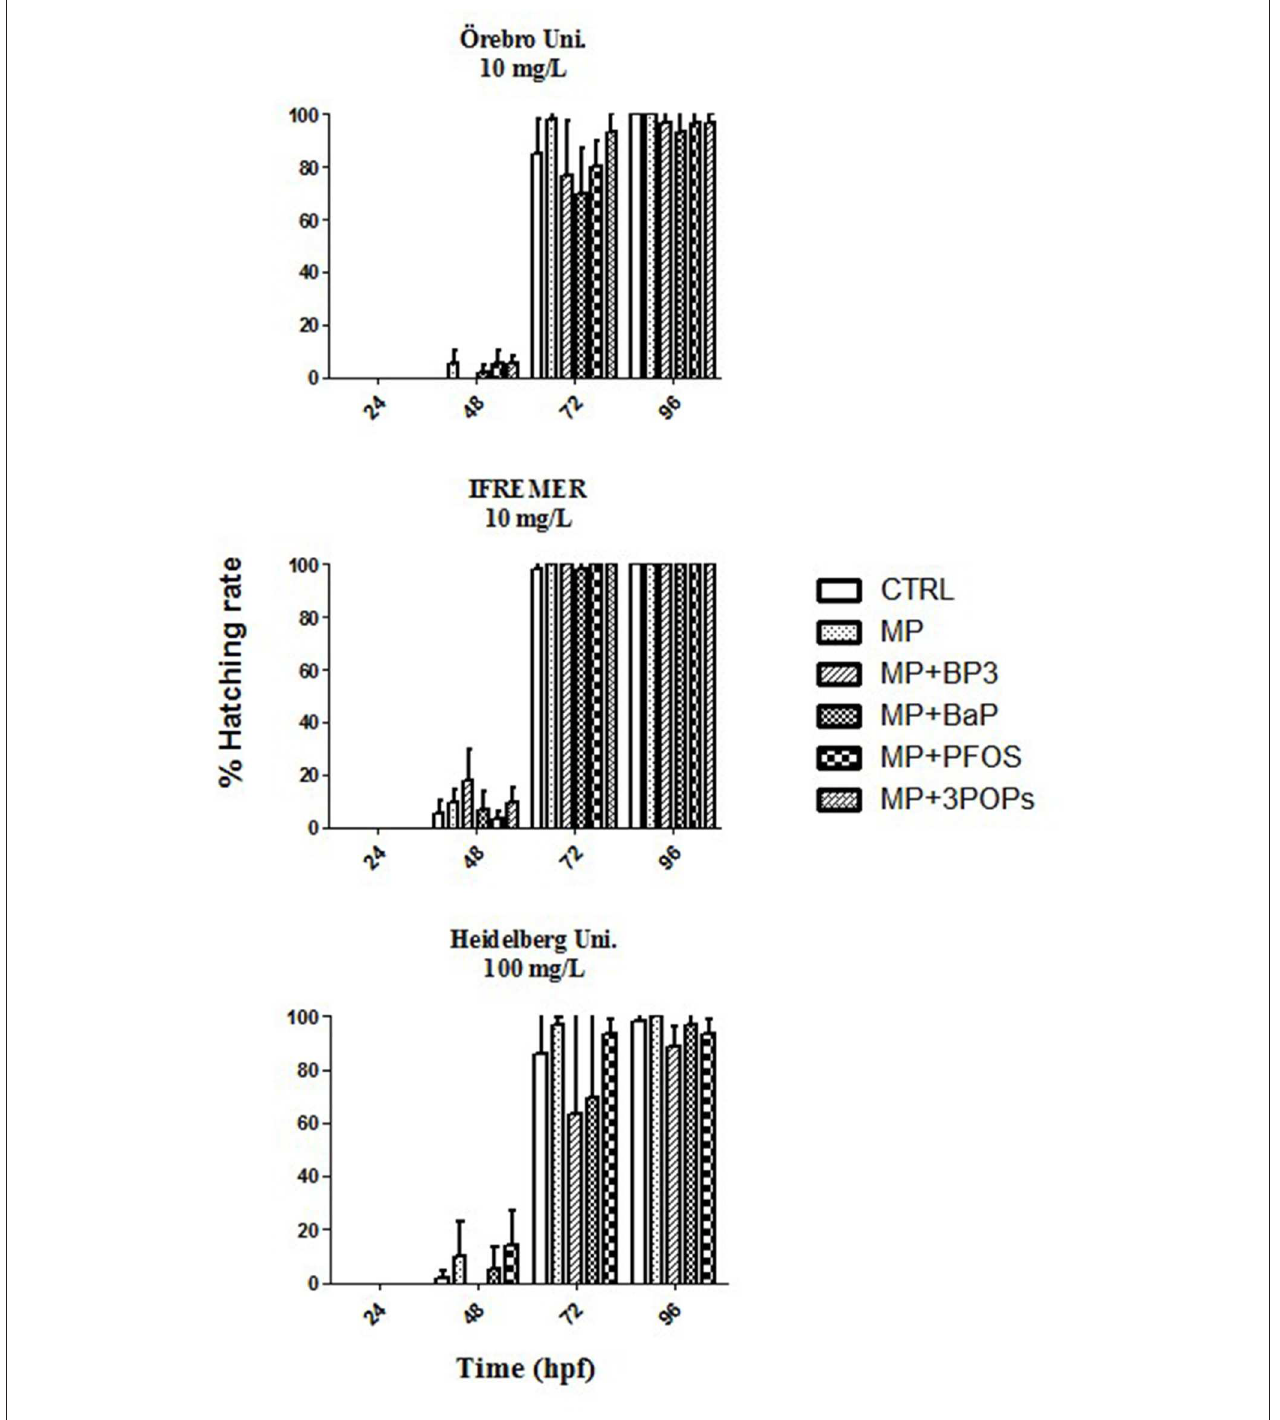
FIGURE 2 | Hatching rate of zebrafish ( Danio rerio ) embryos after 24, 48, 72, and 96h exposure to microplastics (MP) and microplastics spiked with benzophenone 3 (MP + BP3), benzo[a]pyrene (MP + BaP), perfuorooctane sulfonate (MP + PFOS) as well as a mixture of the three pollutants (MP + 3 POPs) in comparison to the control (CTRL). Hatching rate is given as means ± SD from three independent experiments. Kruskal-Wallis analysis: p = 0.05.